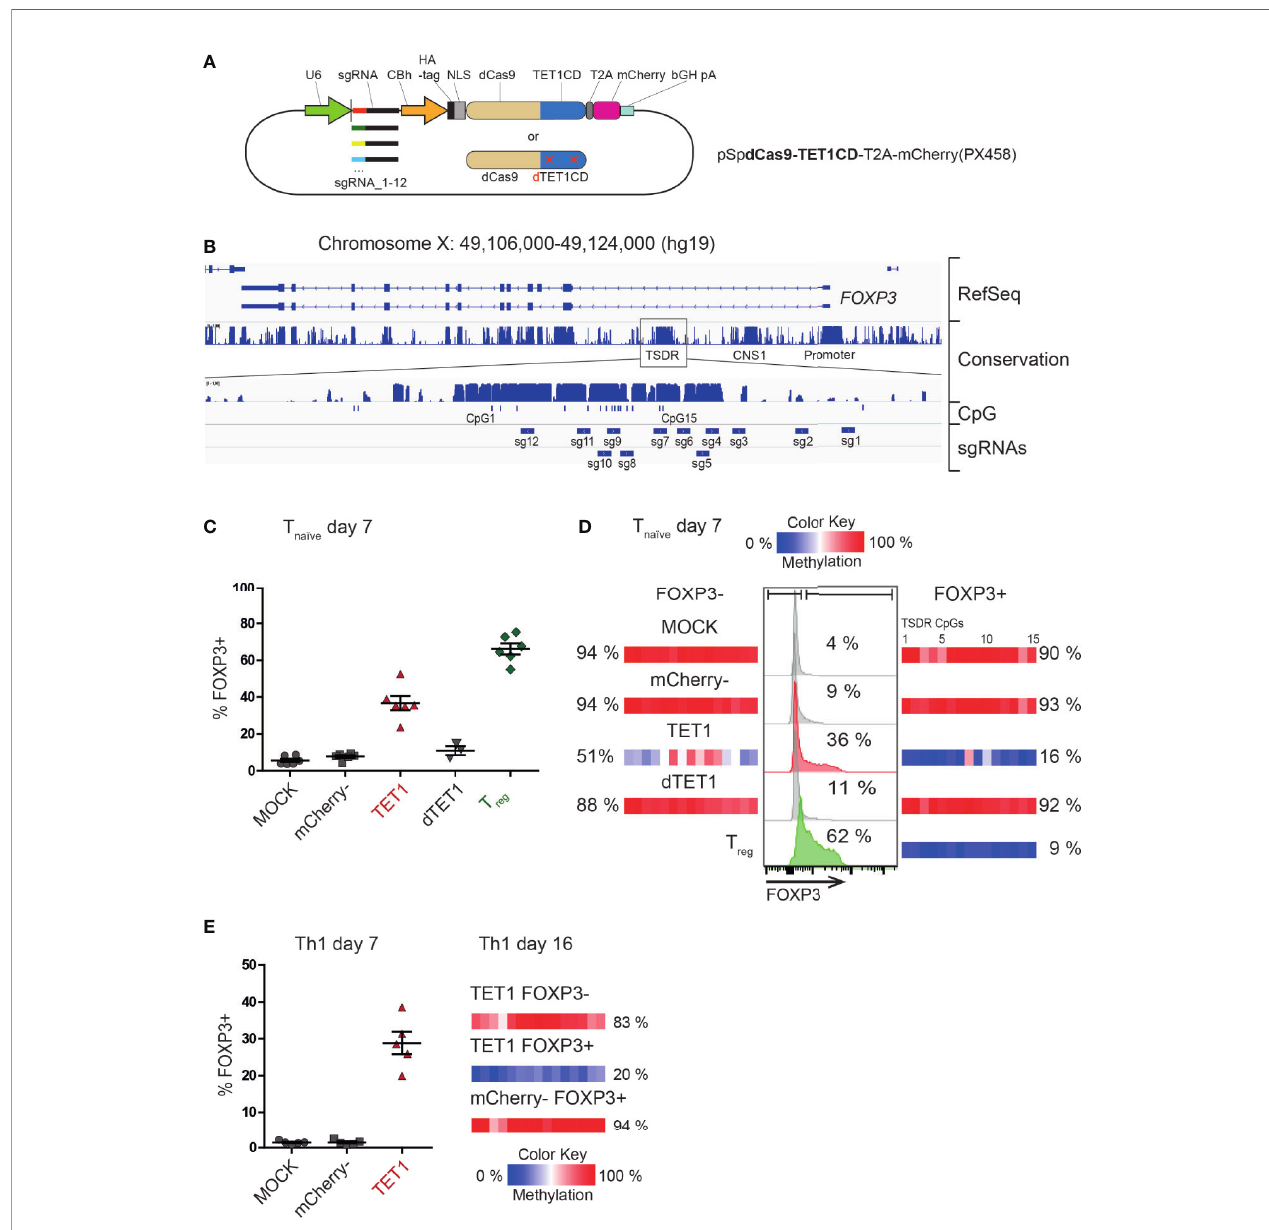
FIGURE 1 | Successful dCas9-TET1CD-mediated targeted de-methylation of the TSDR leads to FOXP3 expression. Ex vivo isolated human naïve CD4+ T cells (T naive ) or Th1-memory T cells were transfected by electroporation with (or without “ MOCK ” ) a mixture of 12 plasmids (A) , each carrying the dCas9-TET1CD fusion protein “ TET1 ” (or the enzymatically dead dCas9-dTET1CD control), one out of 12 single-guide RNA (sgRNA1-12) and a mCherry reporter gene. On day 2 post transfection, cells of the dCas9-TET1CD- transfected sample were sorted by FACS according to mCherry expression (mCherry+ = “ TET1 ” and “ mCherry- ” ). mCherry+ cells of the dCas9-dTET1CD transfected sample were also sorted and used as controls. All samples were re-cultured and analyzed for TSDR methylation and FOXP3 expression at the indicated time-points. Ex vivo sorted CD4+ CD25hi CD127- Treg were cultured for the same time period, left untransfected, and used as positive controls. (B) The highly conserved TSDR in the human FOXP3 locus is shown and the positions of the CpGs as well as the targeted regions for each sgRNA are indicated. (C) Fraction of FOXP3+ cells in the indicated sample groups as assessed by intracellular FACS staining on day 7 post transfection of CD4+ naïve T cells, n = 6, for dTET1 n = 3, the mean and SEM are indicated. (D) Representative histograms of FOXP3 expression in naïve T cell-derived experimental groups (MOCK, mCherry-, TET1 and dTET1) on day 7 post transfection (middle, the fraction of FOXP3+ cells is given in %). Untransfected ex vivo-sorted Treg function as a positive control. On the same day, all populations were sorted into FOXP3- and FOXP3+ fractions. The degree of TSDR methylation after re-sorting (left: FOXP3-, right: FOXP3+) is shown (color scale) for each of the 15 TSDR-CpGs (small boxes). The mean methylation degree of the entire TSDR is given in %. (E) left: Expression of FOXP3 in Th1 memory T cells on day 7 post transfection (the mean and SEM are indicated). right: The degree of TSDR methylation of FOXP3+/- resorted populations and control cells on day 16 is indicated, for each TSDR CpG individually (small boxes with color scale) and as the mean of all (in